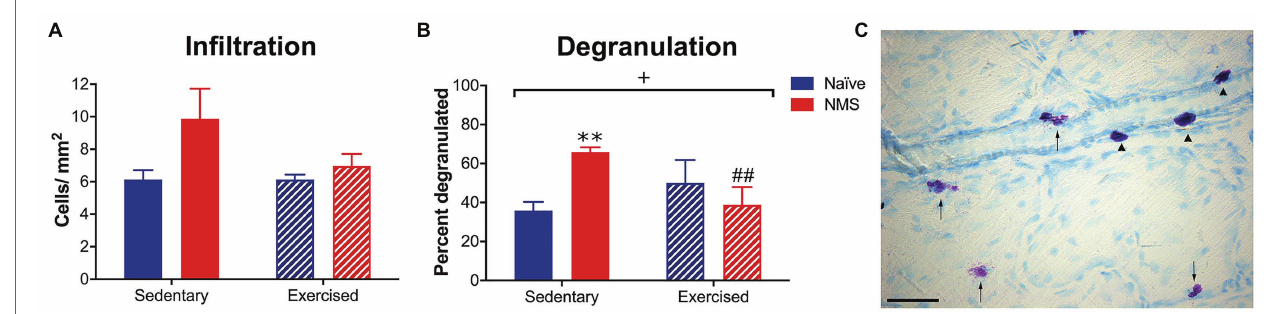
FIGURE 2 | Dura mater was stained with toluidine blue (TB) to visualize mast cells and the total number and percent of degranulated mast cells were quantified in sedentary (Sed) or exercised (Ex) naïve and NMS mice. (A) NMS-Sed mice had a non-significant increase in the number of mast cells in the dura compared to naïve- Sed and NMS-Ex mice. (B) There was a significant NMS/exercise interaction on the percent of degranulated dural mast cells. NMS-Sed mice had a significantly greater percent of degranulated dura mast cells compared to naïve-Sed mice. This effect was attenuated by exercise, as NMS-Ex mice had a significantly lower percent of degranulated mast cells compared to NMS-Sed mice. (C) Representative image of dura mater from an NMS-Sed mouse stained with TB. Arrow heads indicate intact mast cells and arrows indicate degranulated or activated mast cells. Scale bar in C equals 25 μ m. Bracket indicates a significant NMS/exercise interaction ( + p < 0.05), two-way ANOVA; ** p < 0.01 vs. naïve, ## p < 0.01 vs. sedentary, Fisher’s LSD posttest. n =